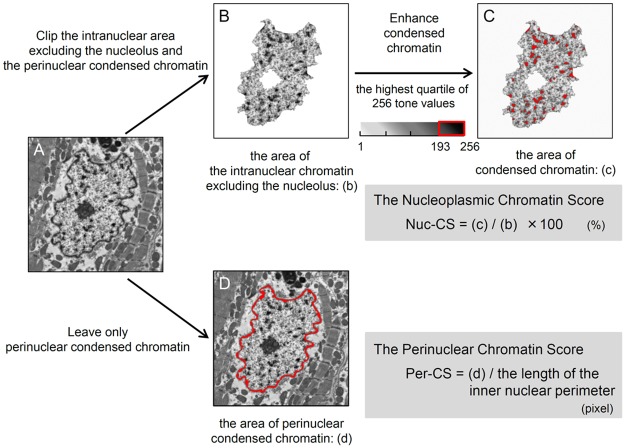
Protocol to Quantitatively Measure Chromatin Area in Group N.Our novel method is composed of the following steps. (A) Representative image prior to the availability of digital analysis (10,000× magnification). (B) The perinuclear condensed chromatin was isolated automatically by image analysis software. The area of the intranuclear chromatin excluding the nucleolus, shown as (b), was measured. (C) The area of condensed chromatin, defined as the area with a grayscale value between 193 and 256, was measured (red). The nucleoplasmic chromatin score (Nuc-CS) was defined as (c) / (b) ×100 (%). (D) The area of perinuclear condensed chromatin, defined as (d), and the length of the inner nuclear perimeter were automatically measured (outlined in red in (D)). The perinuclear chromatin score (Per-CS) was defined as (d) / the length of the inner nuclear perimeter (pixel).